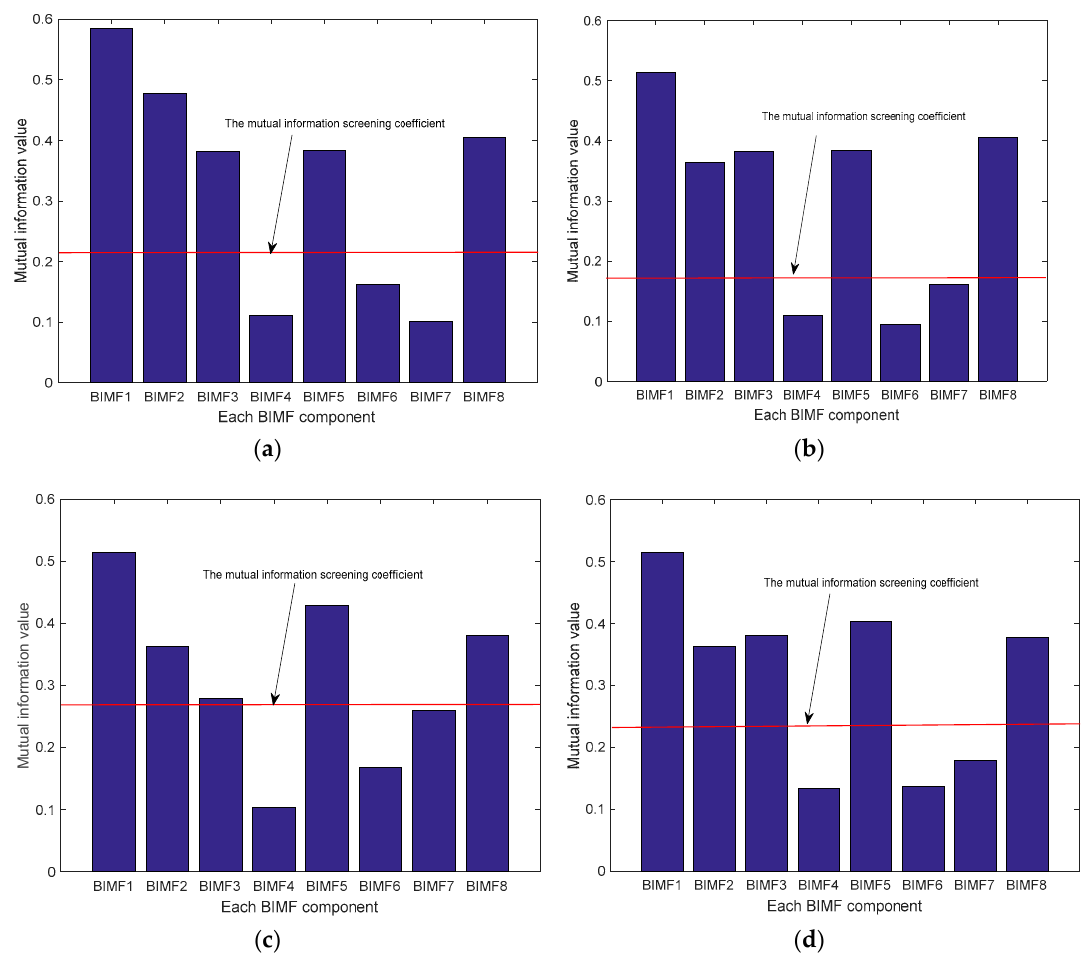
Figure 9. Mutual information of the four conditions in the siphon for 8 BIMF components. ( a ) clean; ( b ) blockage; ( c ) 55 mm longitudinal leak; ( d ) joint unsealed.